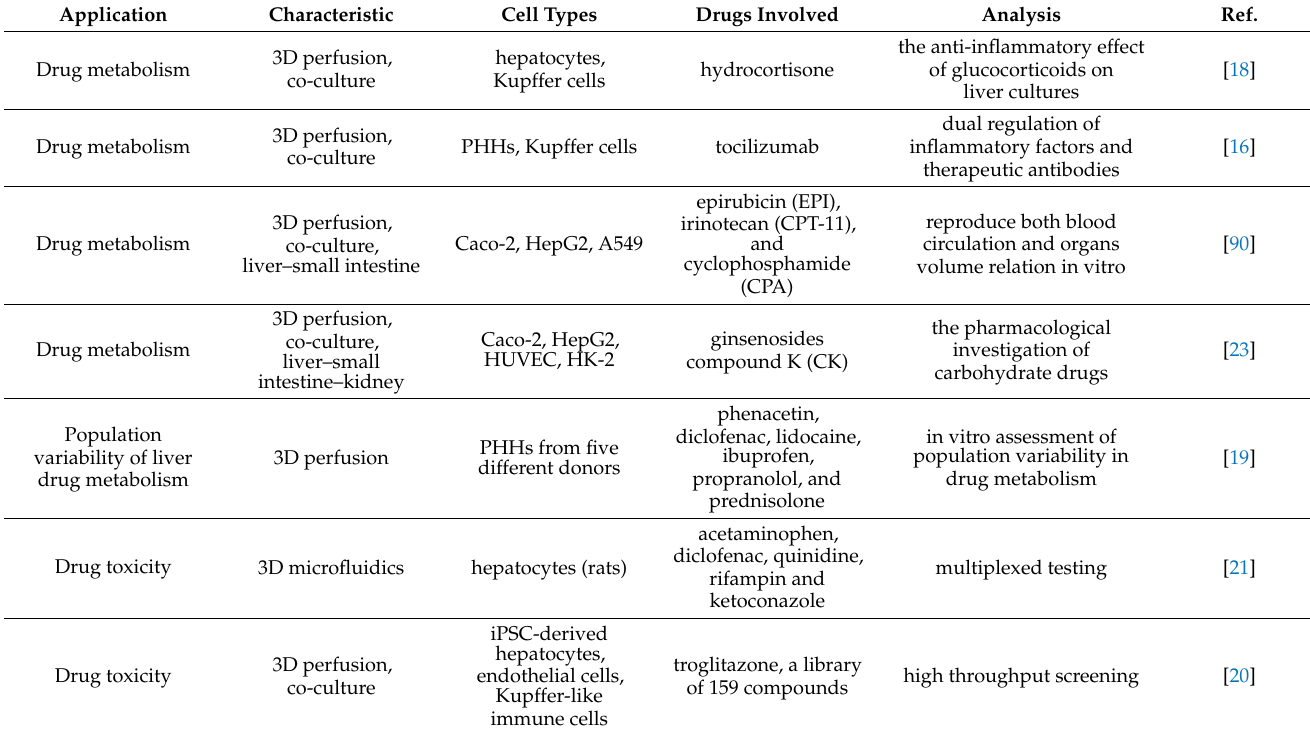
Table 1. Summary of the application of LoC in drug